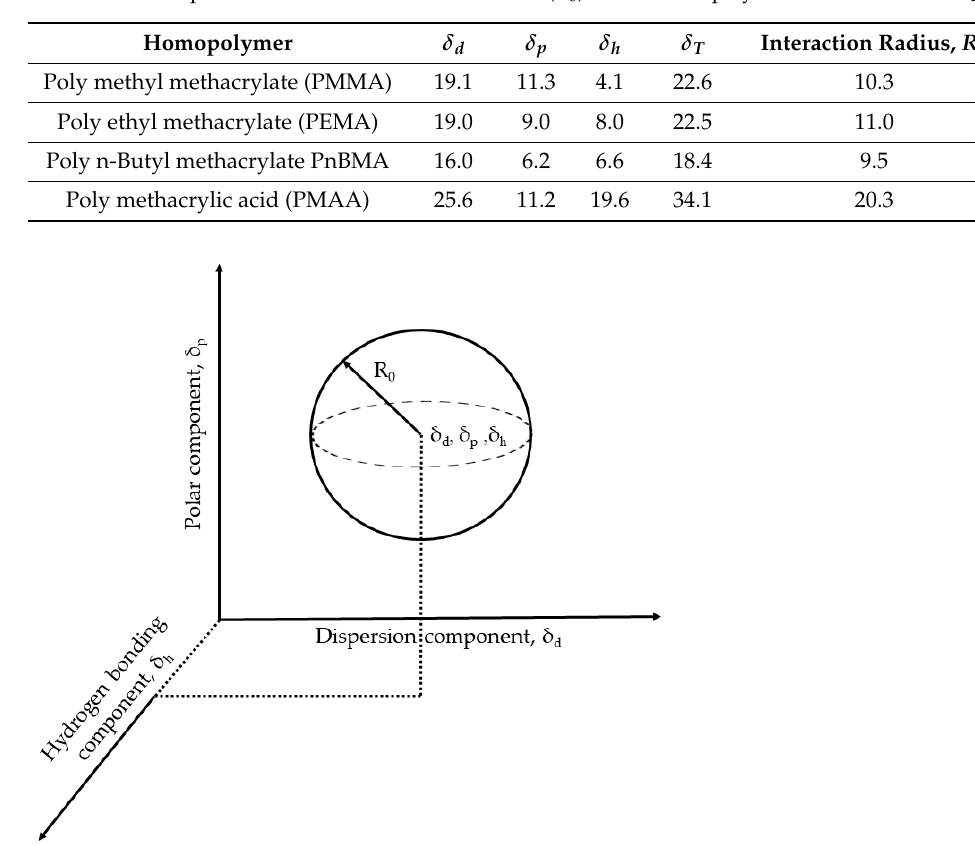
Table 5. Hansen parameters and the interaction radius ( R 0 ) for the homopolymers. Data taken from [32].